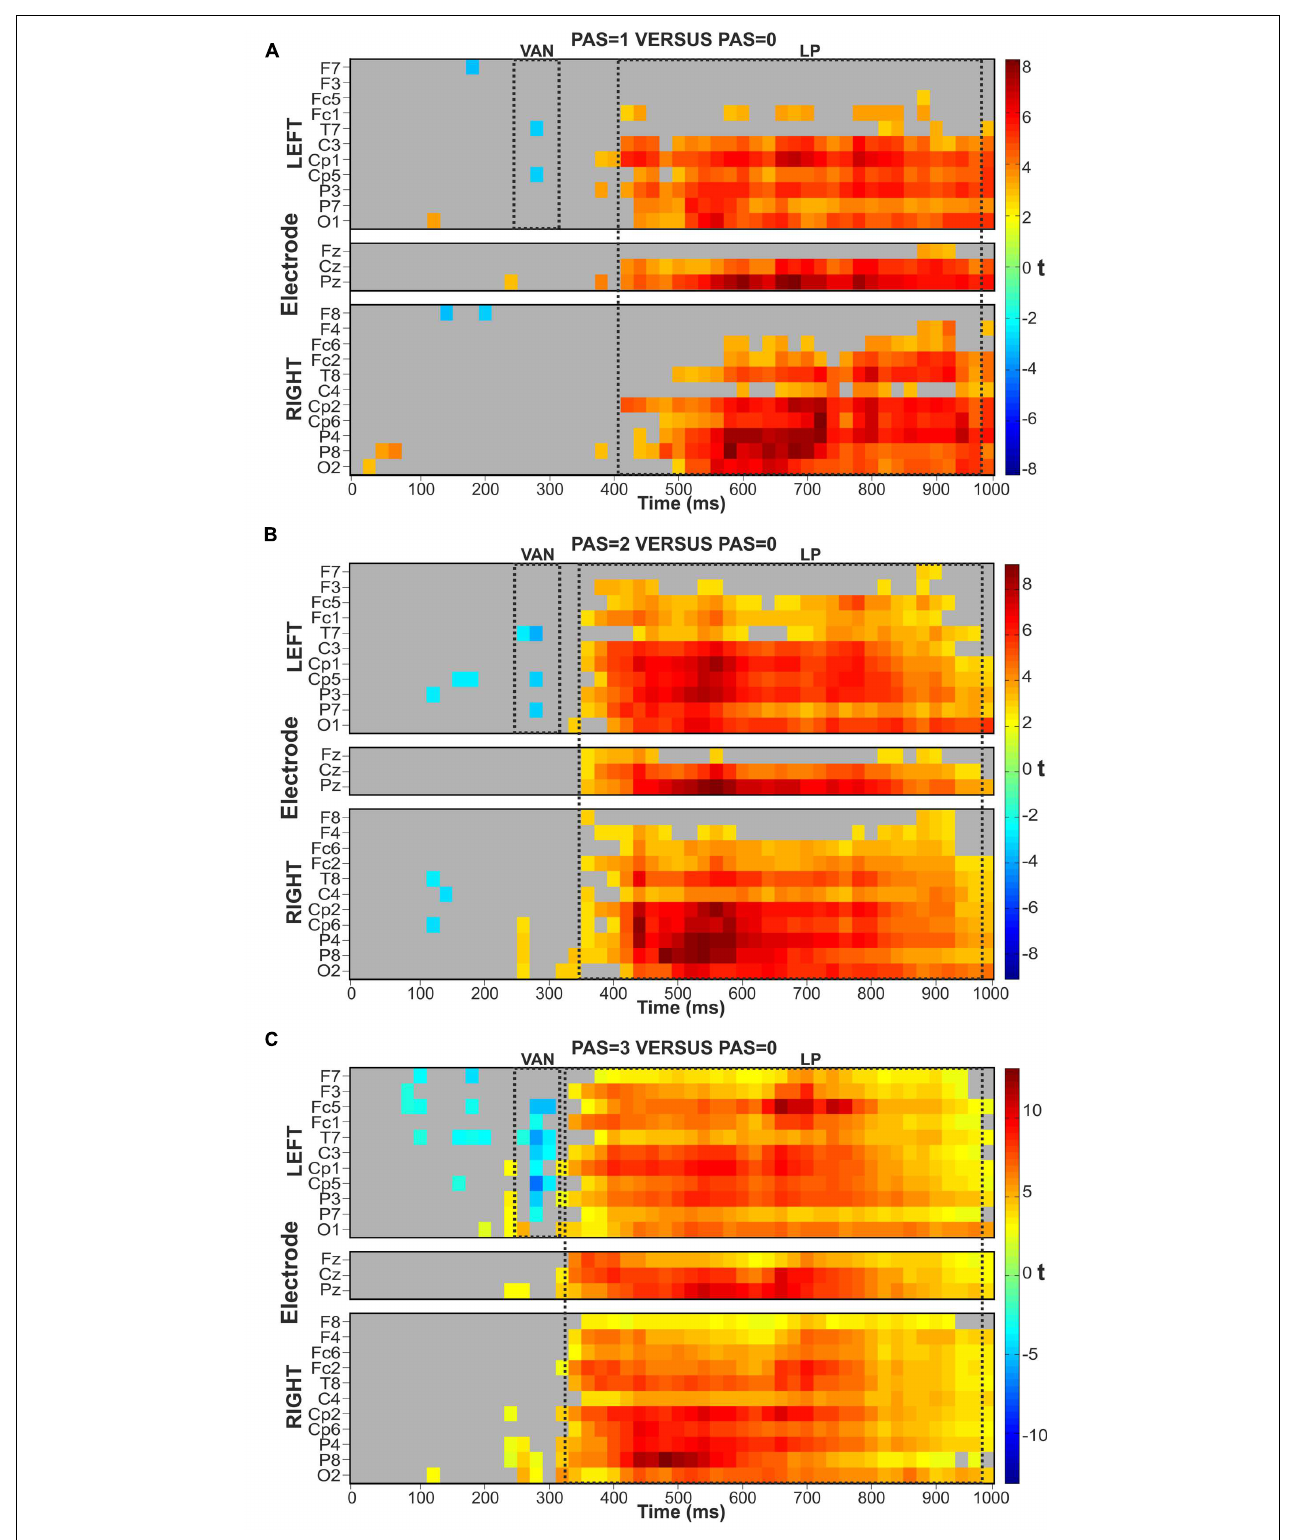
FIGURE 2 | Raster plots. FDR-controlled t -test from Mass Univariate analyses of the three comparisons between each conscious (PAS = 1, 2, and 3) condition and the unconscious (PAS = 0) condition. T -tests were performed on the mean amplitude of consecutive time windows of 20 ms. (A) PAS = 1 versus PAS = 0. (B) PAS = 2 versus PAS = 0. (C) PAS = 3 versus PAS =